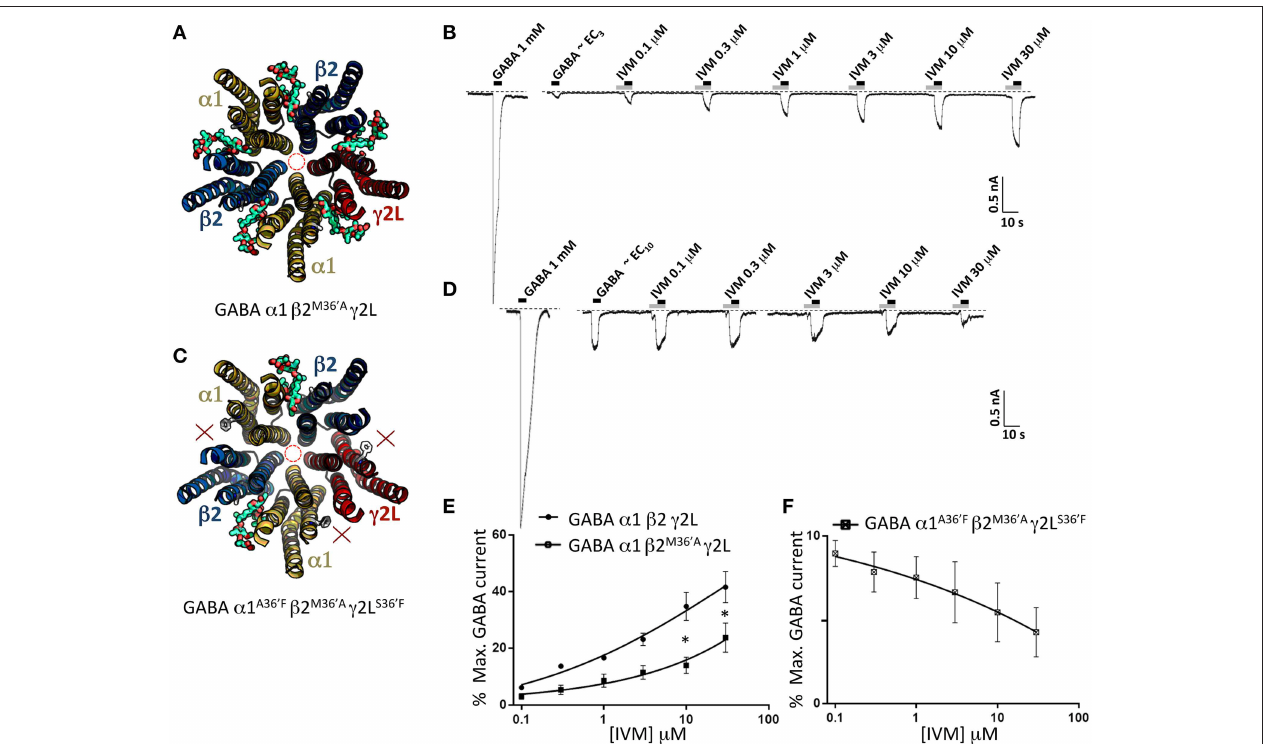
′ A ′ F ′ A ′ F GABA A Rs. (A) Structural model of α 1 β 2 M36 γ 2L and α 1 A36 β 2 M36 γ 2L S36 ′ F ′ A ′ F showing the location of the single ivermectin binding site. (D) Sample recording showing the inhibitory effect of β 2 M36 γ 2L S36 ′ F ′ A ′ F GABA A Rs. (E) Mean concentration-response data for β 2 M36 γ 2L S36